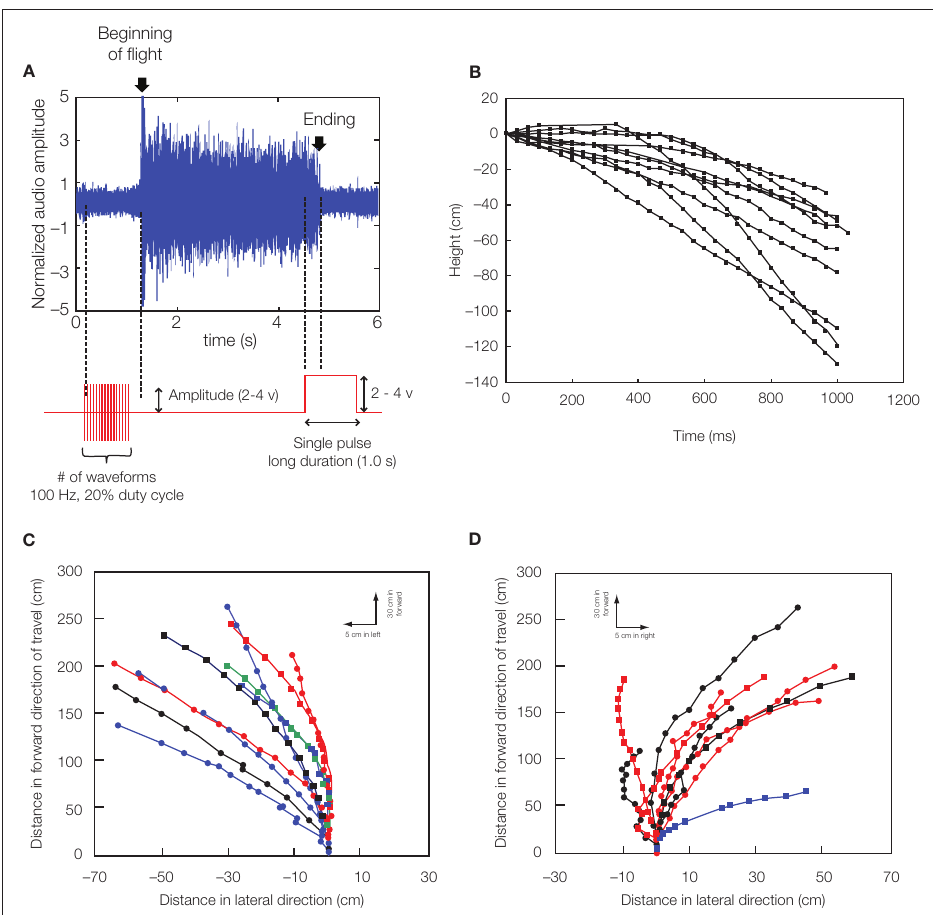
Figure 4 | remote radio control of beetle flight by electrical stimulation. (A) Initiation and cessation control. Alternating positive and negative potential pulses at 100 Hz applied between left and right optic lobes initiated wing oscillations while a single pulse ceased wing oscillations; (top) audio recording of tethered beetle, (bottom) applied potential to the one side optic lobe regarding the other side optic lobe. The sharp rise of audio amplitude at the beginning of oscillation is attributed to friction between elytra and wings when the wings came out from the underneath of elytra. The whole audio amplitudes were normalized by mean absolute value calculated for the middle period of the flight time (2.5–3.7 s). (B) Elevation control of a free-flying beetle: temporal height change of a flying beetle (10 flight paths). Alternating positive and negative potential pulse trains at 100 Hz and 2.0 V amplitude to the brain caused the beetle to fly downward. The median height change was 60 cm (the range was 33–129 cm). (C,D) Turn control of free-flying Mecynorhina torquata beetle. Pulse trains at 100 Hz and 1.3 V positive potential to the left or right basalar muscle triggered turns. Ten flight paths elicited by (A) right or (B) left basalar muscle stimulus for 0.5 s. Each flight path is obtained after the three-dimensional digitized flight path is projected on the XY plane (see Sato et al. 2009b). Different colored and shaped plots show individual beetle flight paths. See Movies S1–S4 in Supplementary Material for the initiation and cessation in free flight (Movie S1) , elevation (Movie S2: tethered, Movie S3: free flight) and turn controls (Movie S4) . Reproduced from Sato et al. (2009b).